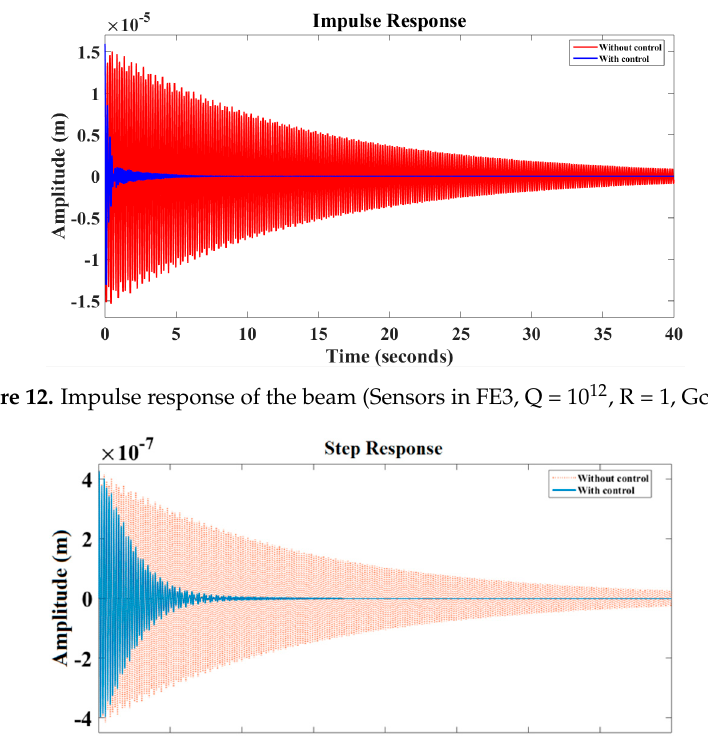
Figure 11. Impulse response of the beam (Sensors in FE3, Q = 10 10 , R = 1, Gc = 100).